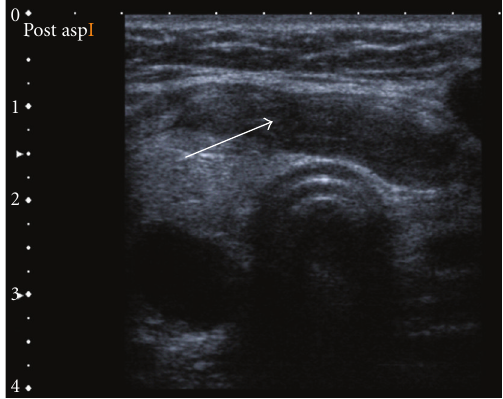
Figure 2: Transverse view of neck showing thick walled cystic mass post aspiration.